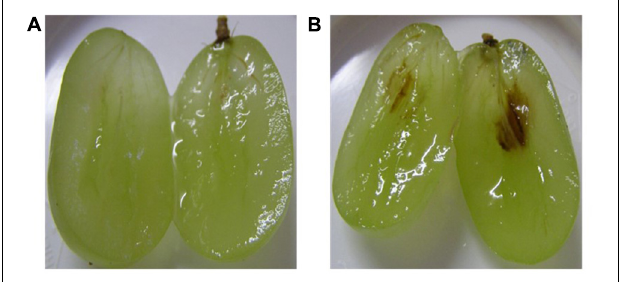
FIGURE 4 | (A) The browning stage of berries in a peach tray after five weeks of cold storage and (B) a berry showing chocolate browning (caused by a fungal infection) and a berry not showing any browning.